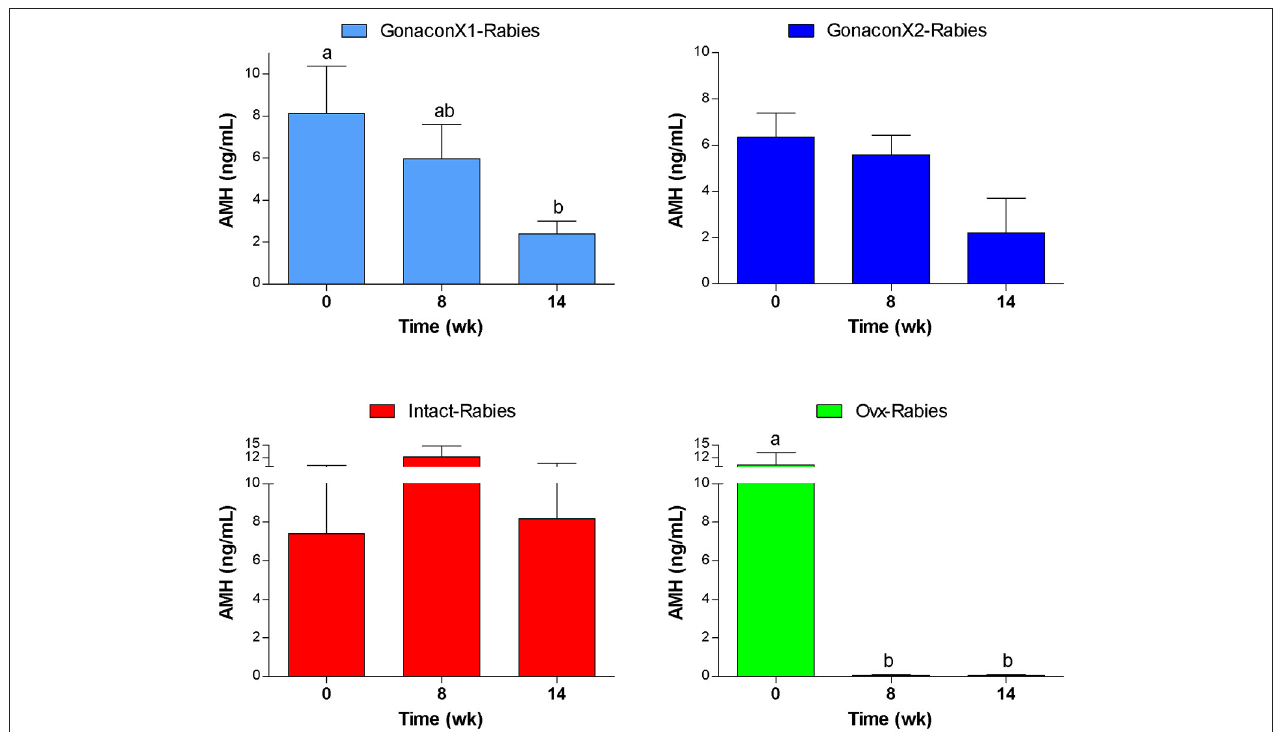
FIGURE 8 | Serum concentrations of anti-müllerian hormone of cats in the research groups. Serum concentrations of anti-müllerian hormone (Mean ± SEM) are presented for each group: GonaconX1-Rabies: cats vaccinated with both Gonacon and rabies ( n = 5); GonaconX2-Rabies: cats vaccinated twice with Gonacon (3 weeks apart) and with rabies ( n = 4); OVx-Rabies: cats ovariohysterectomized and vaccinated with rabies ( n = 4); Intact-Rabies: cats vaccinated against rabies and remained intact ( n = 3). Analyses were performed on blood samples collected at 0, 8, and 14 weeks after the initial vaccination. a,b Different letters above bars represent significant differences ( p <